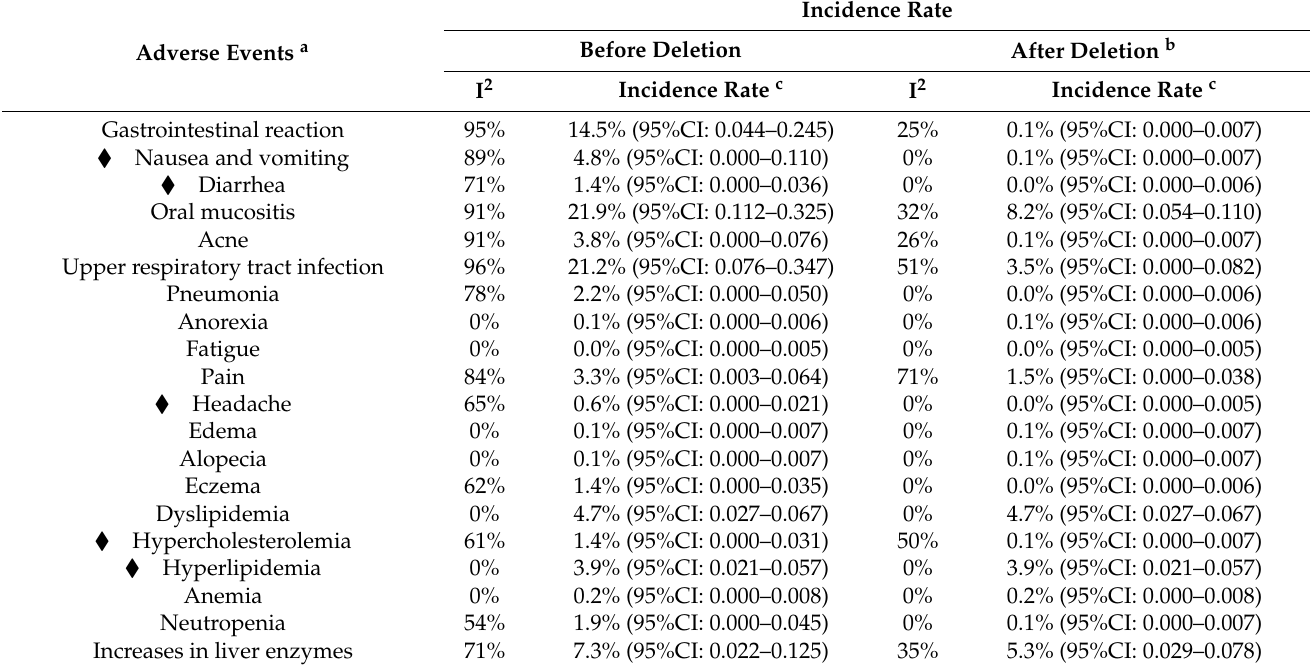
Table 5. List of the incidence rates of adverse events before and after the removal of highly heteroge- neous